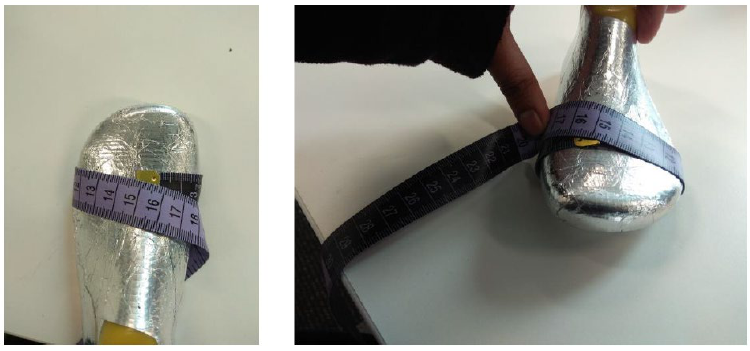
Figure 21. Tape measure wrapped around the widest part of the foot.